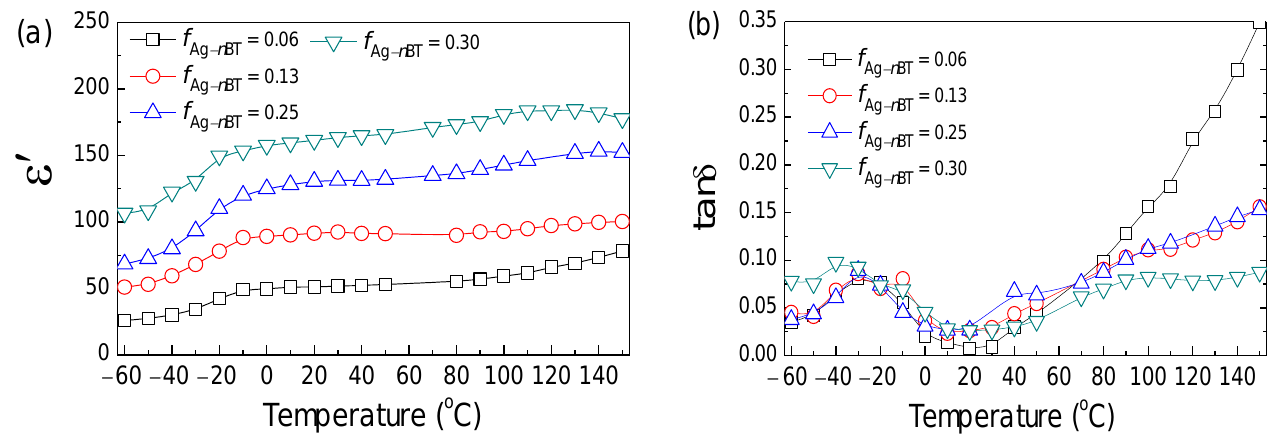
Figure 8. Temperature dependence on dielectric properties ( a ) ε′ and ( b ) tanδ of the Ag- n BT/PVDF-(0.2) μ BT composites with different f Ag-nBT.